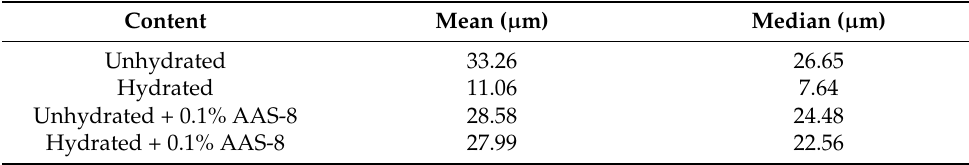
Figure 5. The thermal weight of bentonite under different treatments. 3.6. Scanning Electron Microscopy (SEM) Analysis SEM analysis was performed to evaluate the morphology of bentonite particles modified in various ways. The SEM image of the original sample is displayed in Figure 6a. The SEM image of the sample soaked in water for 24 h (Figure 6b) shows that the size of the particles decreased after being immersed in water. The SEM image of bentonite treated with 0.1% ASS-8 for 24 h (Figure 6c) reveals that the treatment with 0.1% ASS-8 did not seem to affect the bentonite particle size, as they were not much different from the original bentonite, although they were larger than the particles after water treatment.